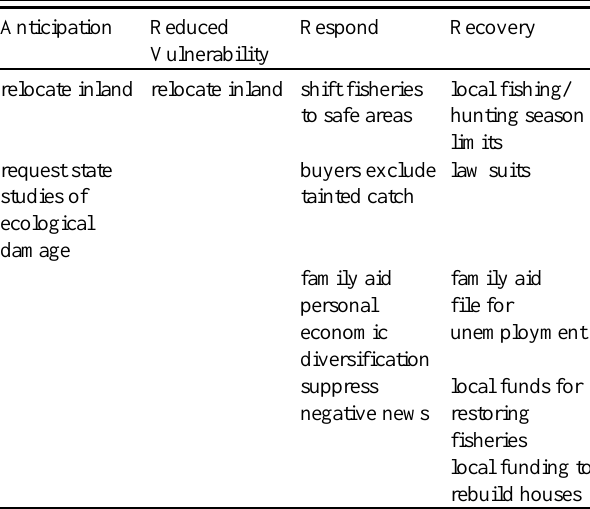
Table 1 . All-hazards inherent resilience before